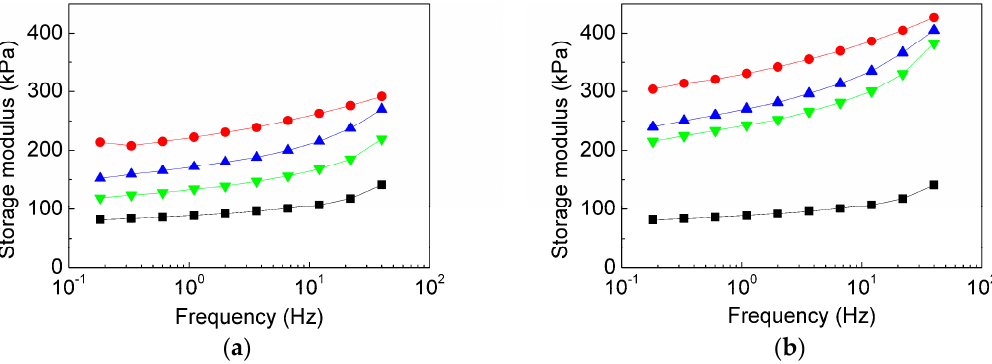
Figure 9. ( a ) Off ‐ state and ( b ) the on ‐ state (860 kA ∙ m − 1 ) storage modulus, G’ , of neat matrix ( black squares ), and the MREs containing bare CI ( red circles ), CI ‐ g ‐ PHEMATMS ‐ 1 ( blue up ‐ triangles ), and CI ‐ g ‐ PHEMATMS ‐ 2 ( green down ‐ triangles ) particles as a function of frequency.